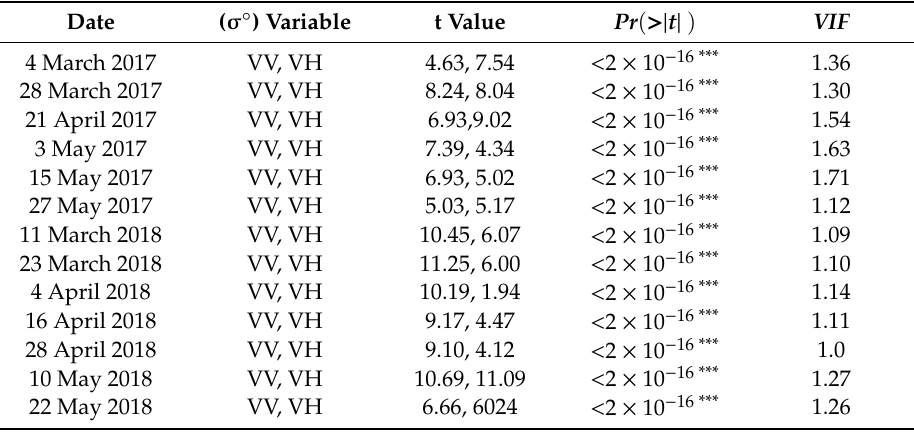
Table 8. Analysis of variance in the localized